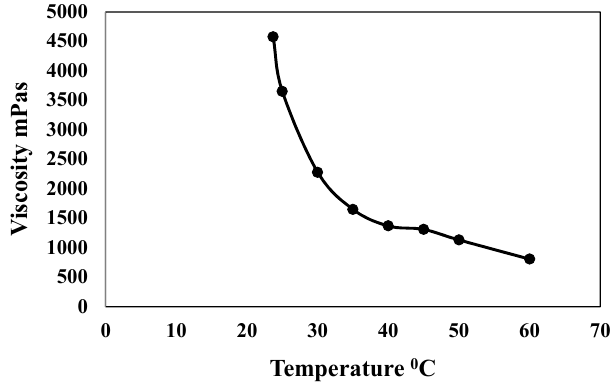
Figure 1. Variation of viscosity of DPFS with temperature.